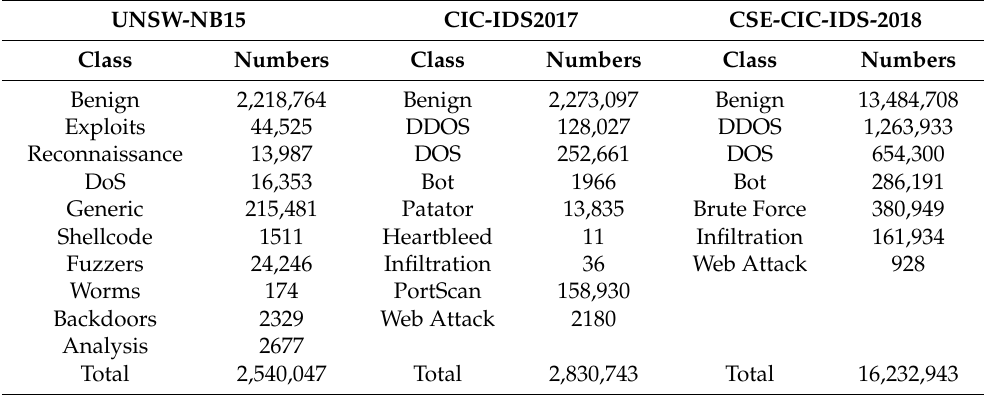
Table 1. Statistics of UNSW-NB15, CIC-IDS2017, and CSE-CIC-IDS-2018